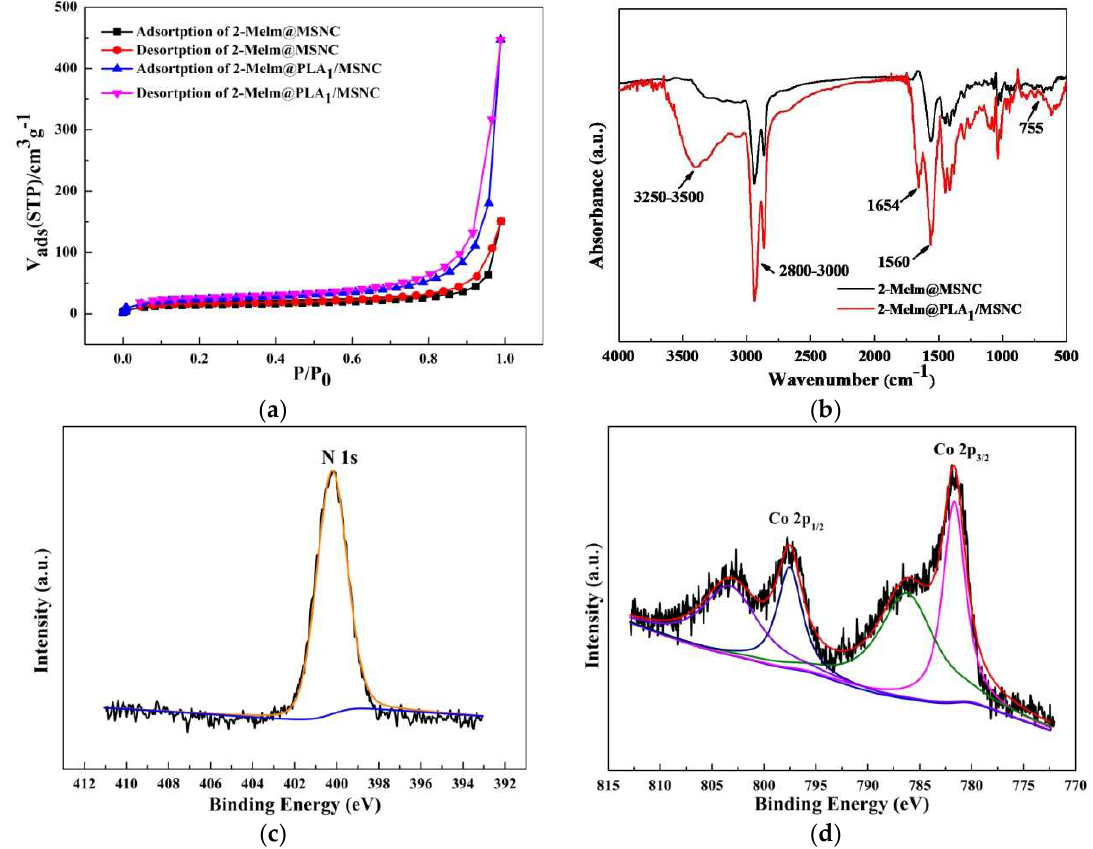
Figure 3. ( a ) N 2 adsorption isotherm of 2-Melm@MSNC and 2-Melm@PLA 1 /MSNC; ( b ) FTIR spectra of 2-Melm@MSNC and 2-Melm@PLA 1 /MSNC; ( c ) high-resolution XPS spectra of N 1s of 2-Melm@PLA 1 /MSNC; ( d ) high-resolution XPS spectra of Co 2p of 2-Melm@PLA 1 /MSNC.